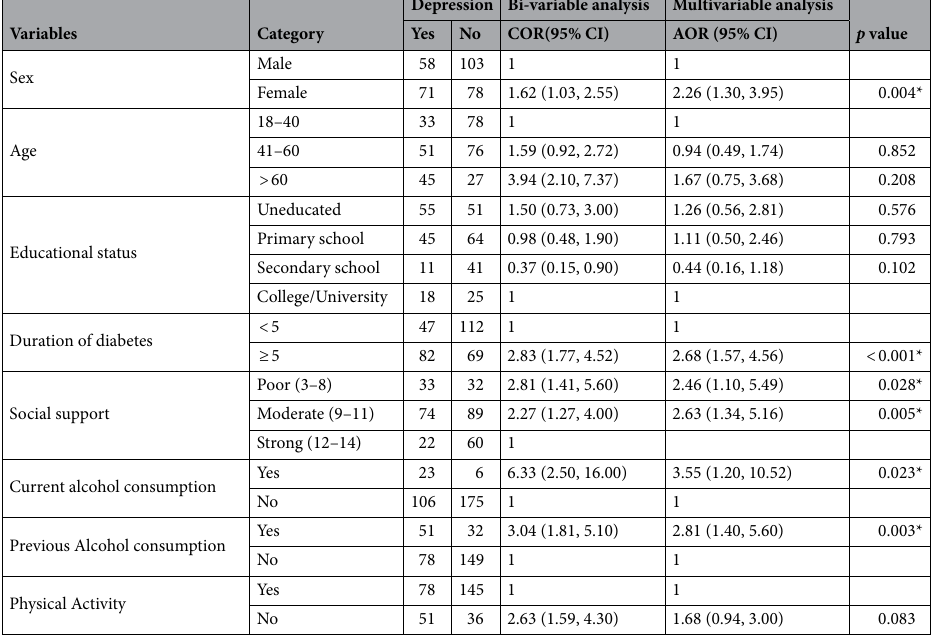
Table 3. Bi-variable and multivariable analysis of factors associated with depression among study participants, 2021. *Statistically significant at p value < 0.05, COR = crude odds ratio at 95% confidence interval; AOR = adjusted odds ratio at 95% confidence